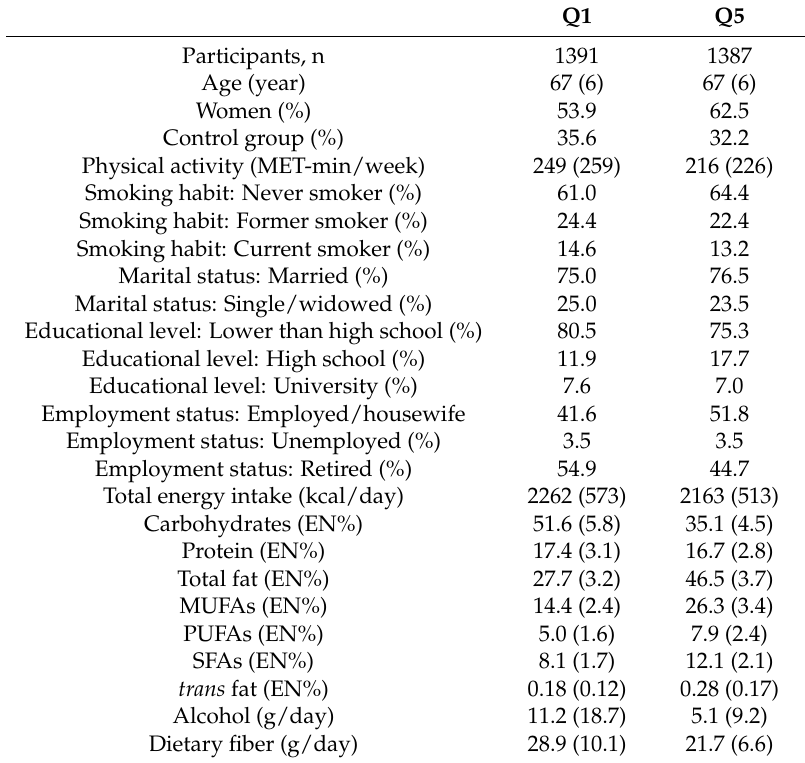
Table 1. Participant characteristics according to extreme quintiles of total fat (in EN%) at baseline 1 .